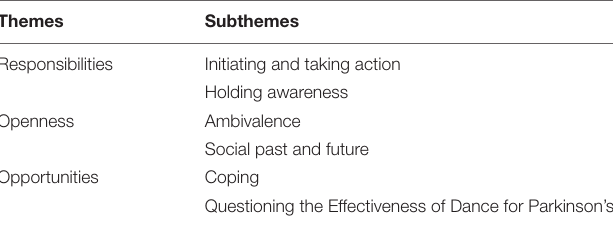
TABLE 3 | Themes from the interviews with partners of those with